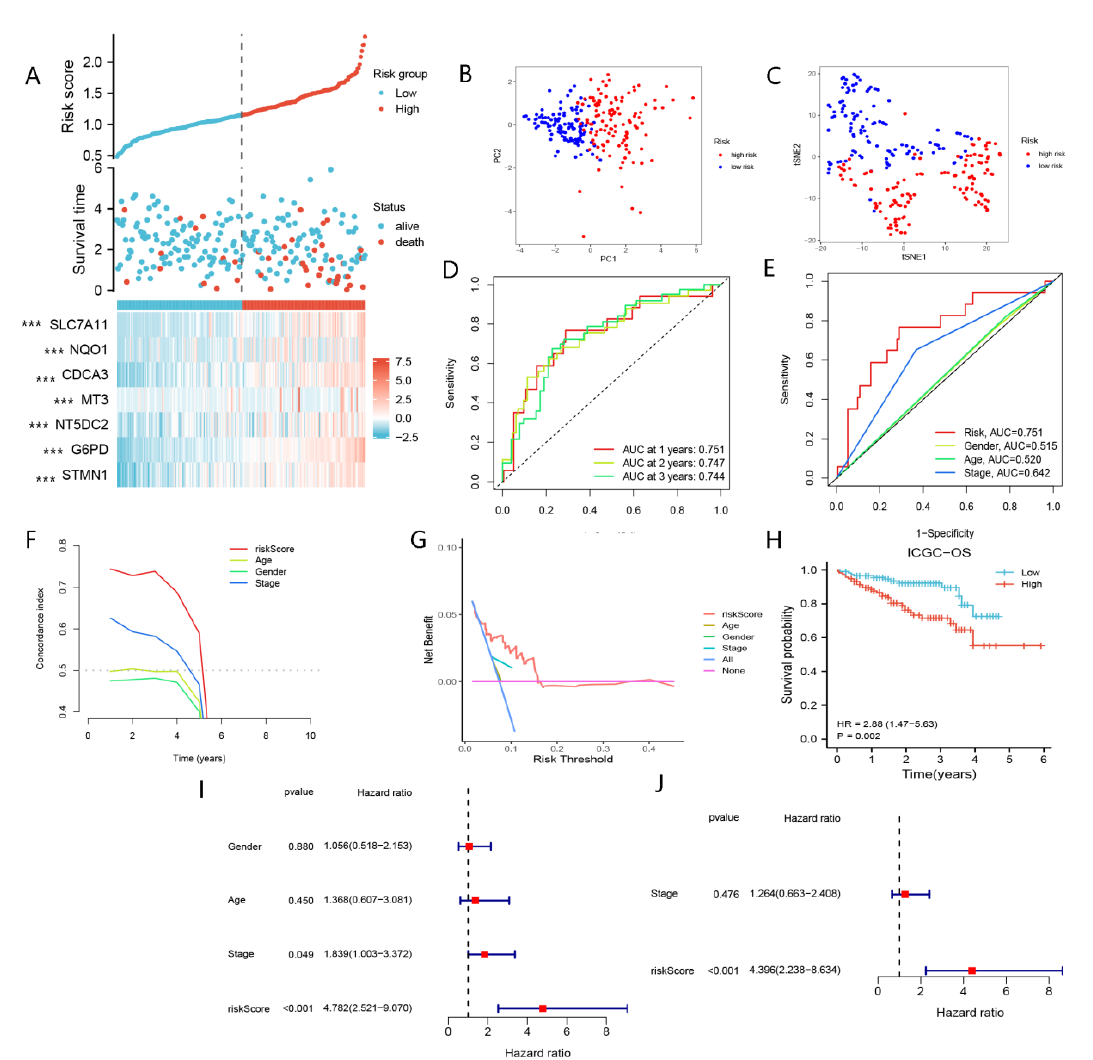
Figure 4. Validation of nFRGs in ICGC. ( A ) Risk score distribution map. ( B ) PCA plot. ( C ) t-NSE plot. ( D ) Time ROC curve of nFRGs. ( E ) ROC curve of nFRGs and other indicators. ( F ) C-index curve of nFRGs and other indicators. ( G ) DCA curve of nFRGs and other indicators. ( H ) KM curve of OS. ( I ) Univariate Cox analysis of risk score, gender, stage and age. ( J ) Multivariate Cox analysis of risk score and stage. (*** representing p < 0.001).